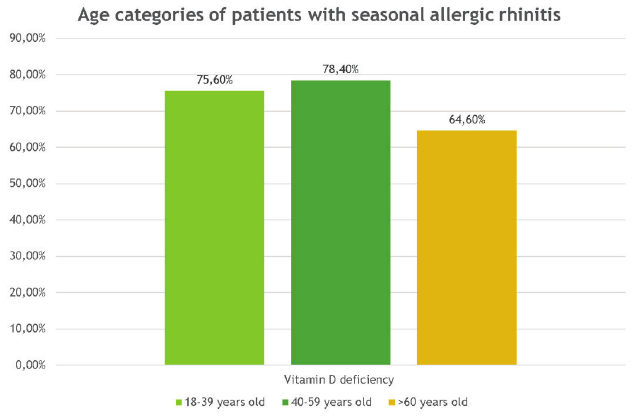
Figure 5b - correlation the nasal discharge with vitamin D concentration